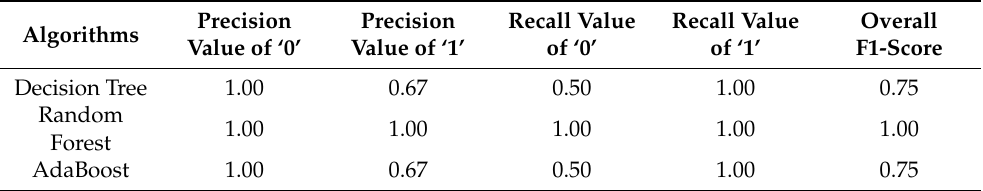
Figure 2. ( a ) Variation of Loss function with respect to number of epochs; ( b ) Decision Tree Classifi- cation Plot; ( c ) Confusion Matrix plot (i) Decision Tree (ii) Random Forest (iii) Ada-Boost; ( d ) ACU Curve (i) Decision Tree (ii) Random Forest (iii) Ada-Boost. Table 4. Metrics features of Classification Based